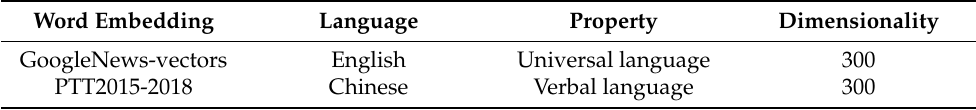
Table 1. The detailed attributes of the Word2Vec